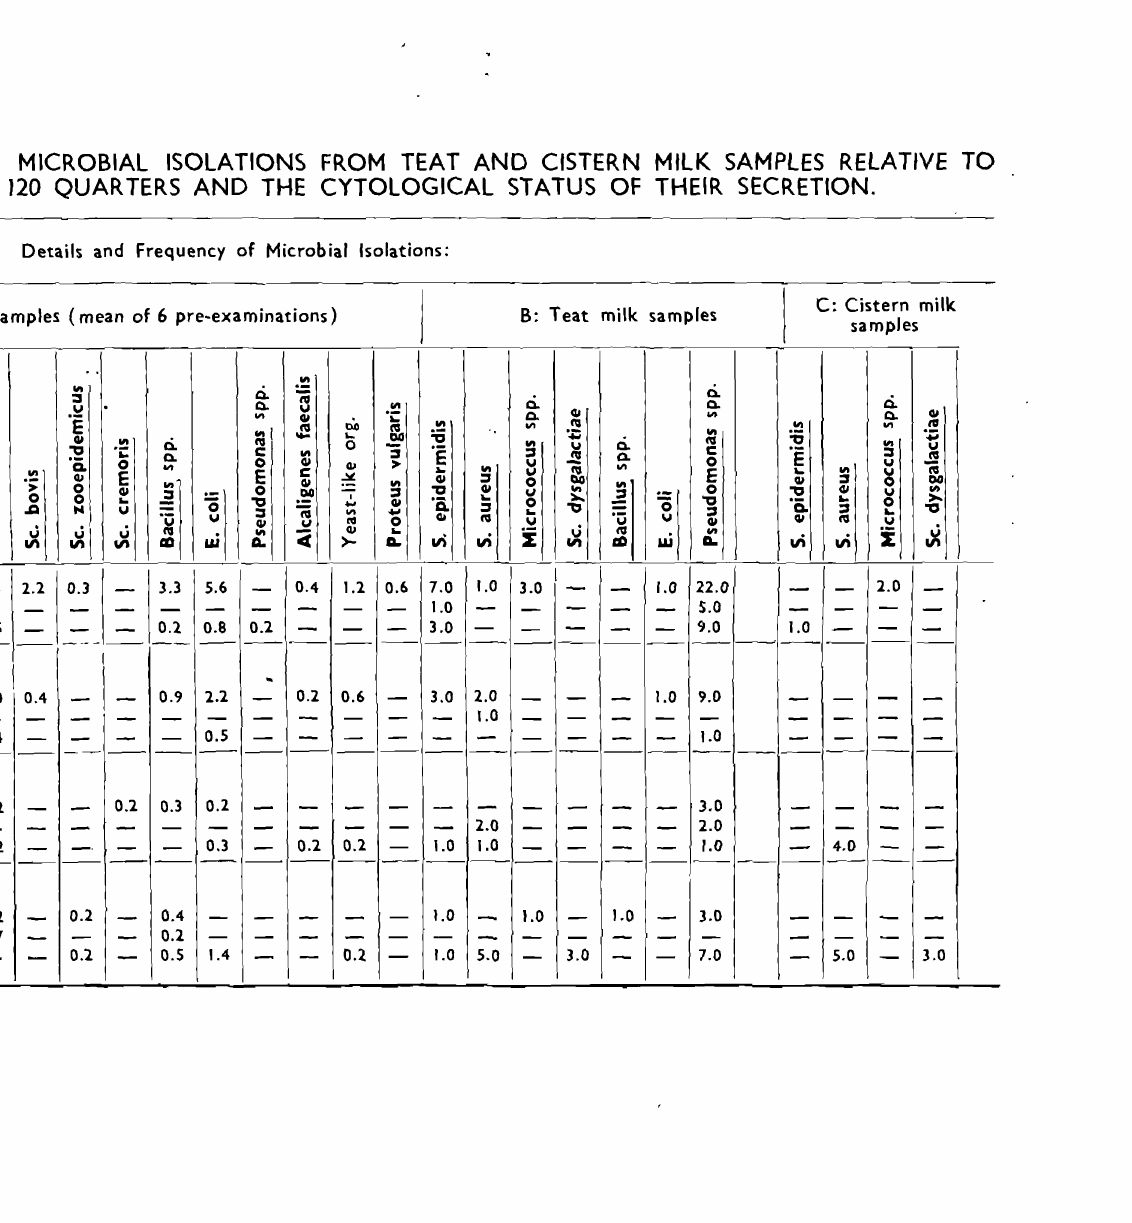
· Table 6--FREQUENCY AND TYPE OF MICROBIAL ISOLATIONS FROM TEAT AND CISTERN MILK SAMPLES RELATIVE TO THE CLINICAL STATUS OF 120 QUARTERS AND THE CYTOLOGICAL STATUS OF THEIR SECRETION. Details and Frequency of Microbial Isolations: Clinical State of Quarter and Cyto logical State of